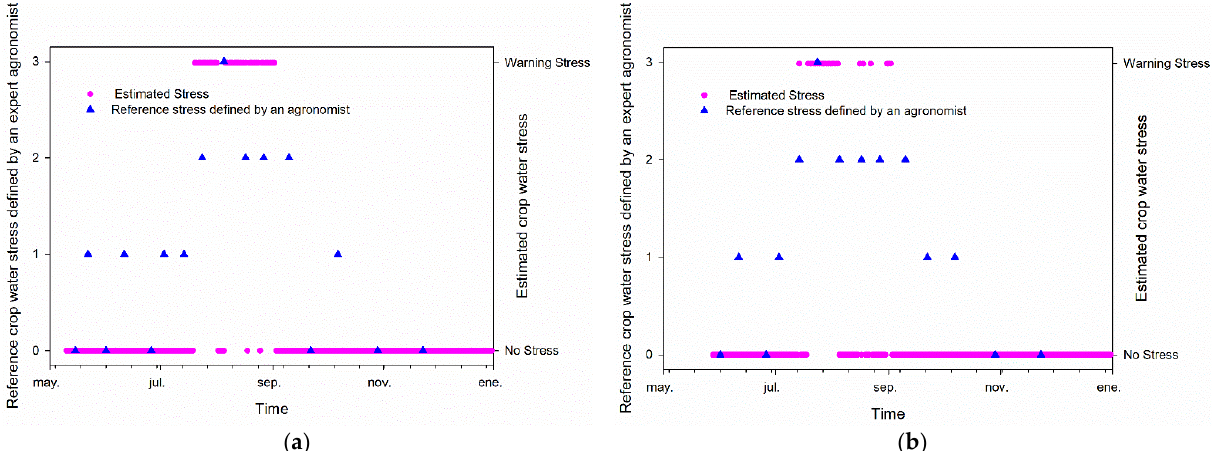
Figure 5. Comparison of crop water stress level estimated with the classification RF model trained with Configuration 2 and T = 10 days and the reference crop water stress level defined by an expert agronomist in [43] for FMR ( a ) and RDC-2 ( b ) irrigation treatments during 2015.